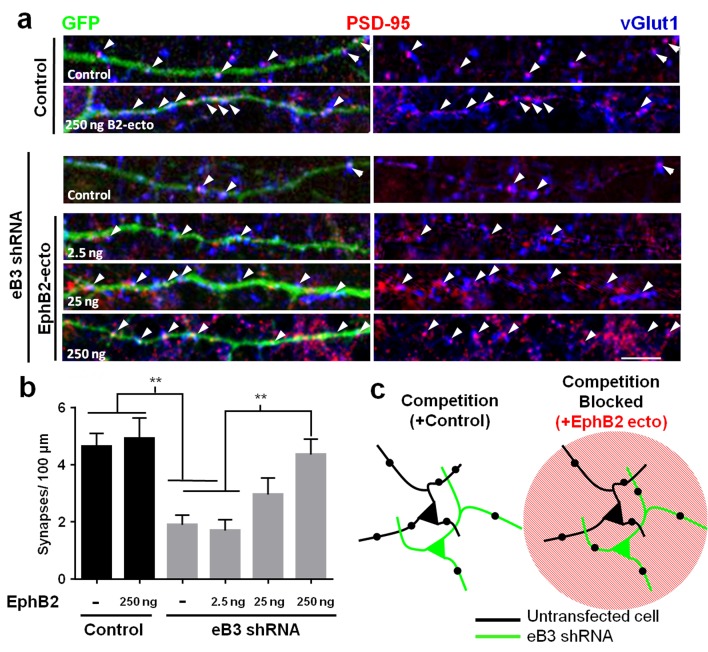
Effects of ephrin-B3 knockdown are rescued by unclustered EphB2 ectodomain treatment.(a) DIV10 cortical neurons transfected with the indicated constructs along with GFP and treated with unclustered EphB2 ectodomain (EphB2-ecto). Arrowheads indicate colocalized PSD-95 (red) and VGlut1 (blue) puncta along GFP-labeled dendrite. (b) Quantification of colocalized PSD-95 and VGlut1 puncta density (Control/ctrl, n = 22; ctrl/B2-Fc 250 ng n = 19; eB3 shRNA/ctrl, n = 38; eB3 shRNA/B2-Fc 2.5 ng, n = 25; eB3 shRNA/B2-Fc 25, ng n = 22; eB3 shRNA/B2-Fc 250 ng, n = 26; F (5,146)=8.454, p<0.0001, one-way ANOVA, **p<0.01 (c) Model of the effect of unclustered EphB2 ectodomain treatment on adjacent neurons within complex cultures. Black dots represent synapses.10.7554/eLife.41563.010Figure 4—source data 1.Effects of ephrin-B3 knockdown are rescued byEphB2 ectodomain.